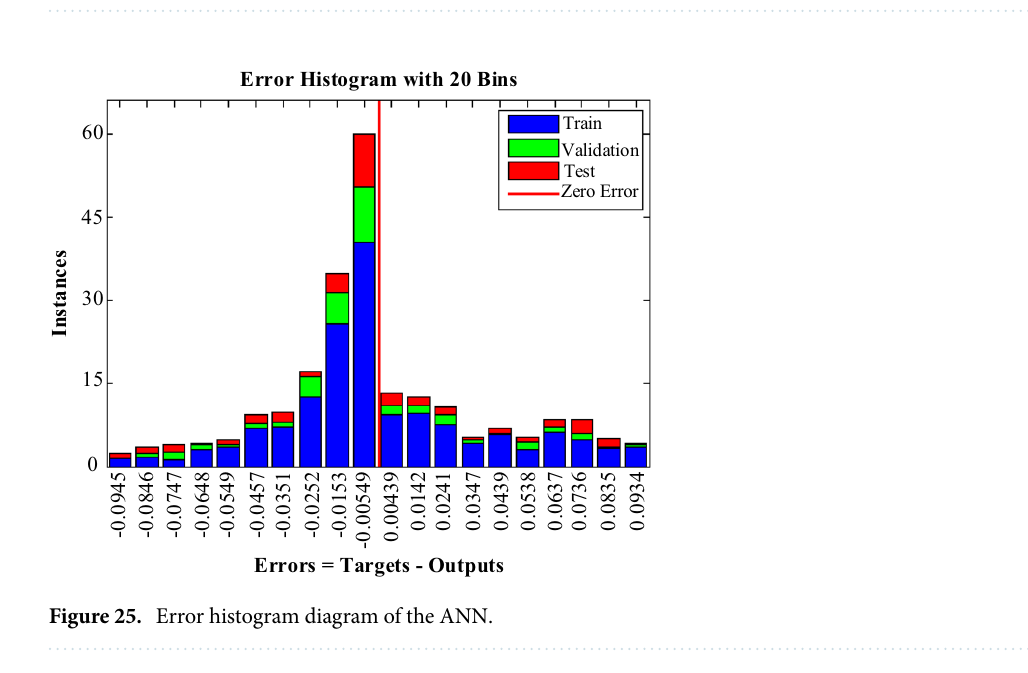
Figure 24. Performance diagram of the ANN.